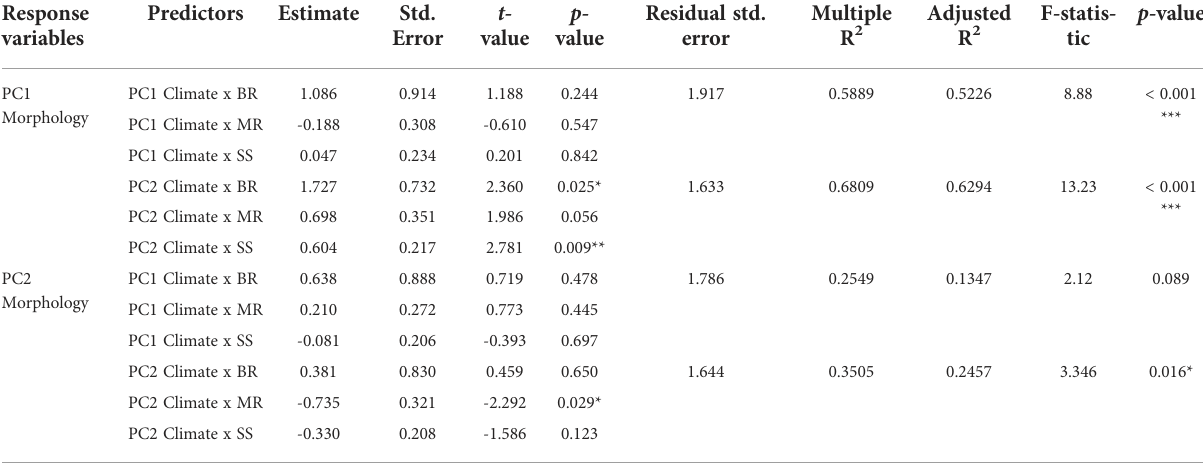
TABLE 2 Phylogenetic generalized least squares models (PGLS) results of climate and morphology interactions among growth forms. Response